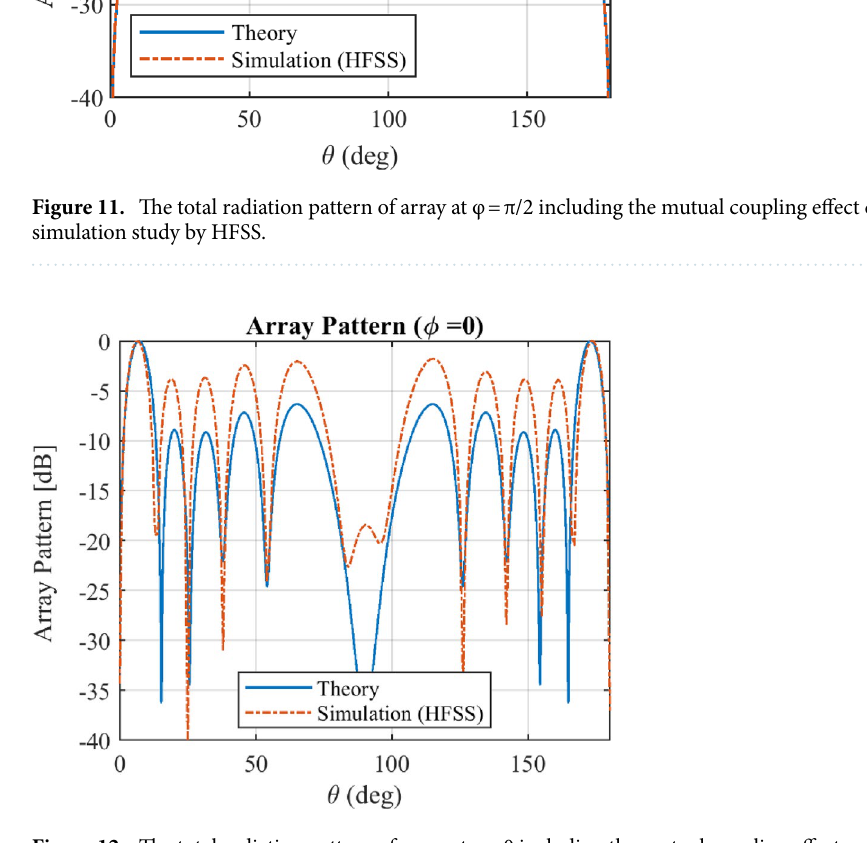
methods is presented. The obtained results show that the introduced method has a good performance in reduc- ing the mutual coupling and number of array elements, while still retaining a good ability to approximate the desired pattern fairly faithfully, especially for beam-shaped patterns.